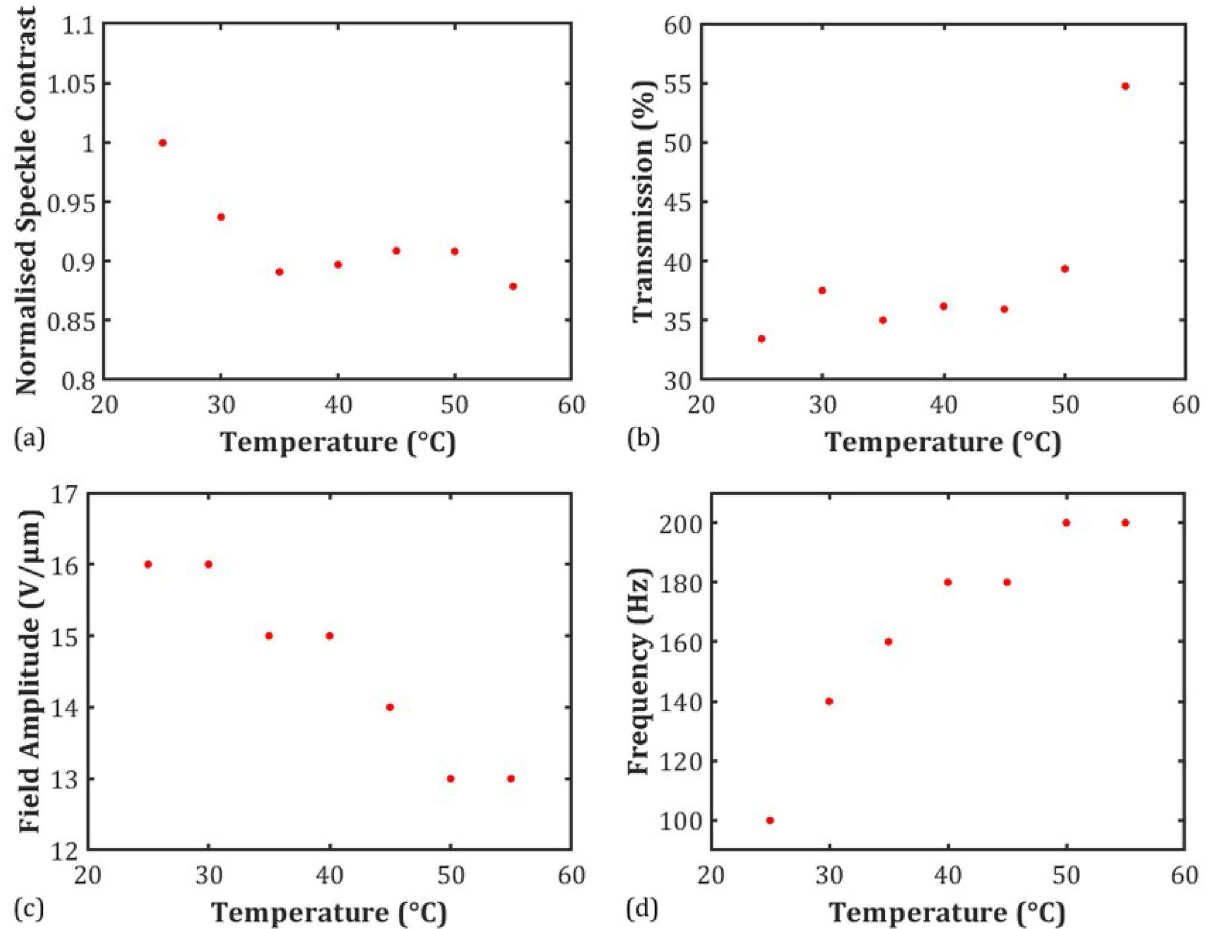
Figure 7. The temperature dependence of ( a ) minimum speckle contrast normalised to the value of C at 25 °C, ( b ) transmission, ( c ) electric field amplitude and ( d ) frequency at the minimum speckle contrast conditions. Devices were nominally 20 µm-thick and contained the chiral nematic LC mixture, E7 + 5.1 wt% BDH1281, which had a pitch of p = 273 nm at 25